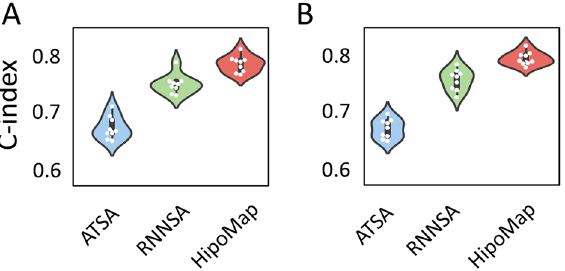
Figure 10. C-index with ( A ) CAT-Net and ( B ) GB in the benchmark methods and our proposed HipoMap for survival analysis.